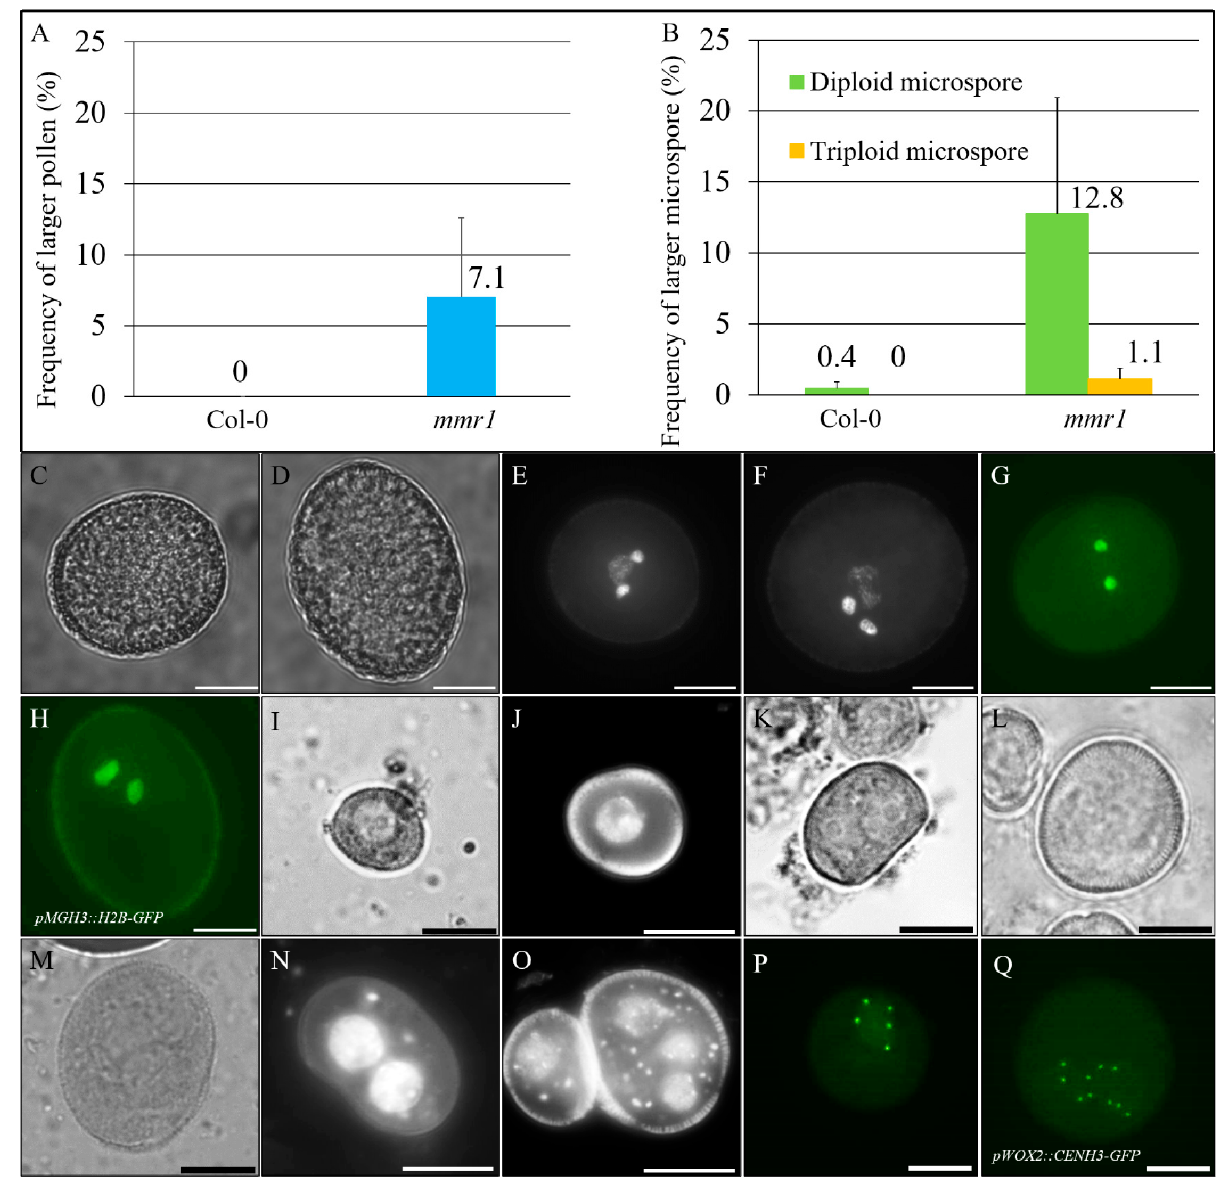
Figure 1. Male meiotic restitution 1 ( mmr1 ) generates unreduced gametes. ( A , B ) Histograms showing the frequency of enlarged pollen grains ( A ) and diploid and/or triploid unicellular stage microspores ( B ) in mmr1 . Error bars represent standard deviation of the mean values. Numbers indicate the average rate of the corresponding phenotypes. Three bio-replicates were analyzed. ( C , D ) Bright field images of mature pollen grains in Col-0 ( C ) and mmr1 ( D ). ( E , F ) DAPI-stained mature pollen grains in Col-0 ( E ) and mmr1 ( F ). ( G , H ) Mature pollen grains expressing pMGH3::H2B-GFP in Col-0 ( G ) and mmr1 ( H ). ( I , J ) Unicellular stage microspores by bright field imaging ( I ) and DAPI-staining ( J ) in Col-0. ( K – O ) Unicellular stage microspores by bright field imaging ( K, diploid; L , triploid; M , tetraploid) and DAPI staining ( N , diploid; O , triploid) in mmr1 . ( P , Q ) Unicellular stage microspores expressing pWOX2::CENH3-GFP in Col-0 ( P ) and mmr1 ( Q ). Scale bars = 10 µm.